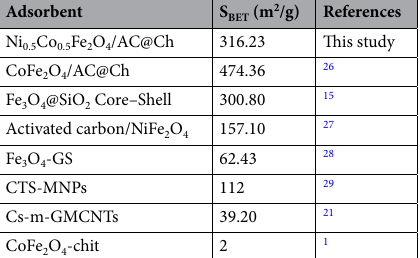
Adsorbent S BET (m 2 /g)